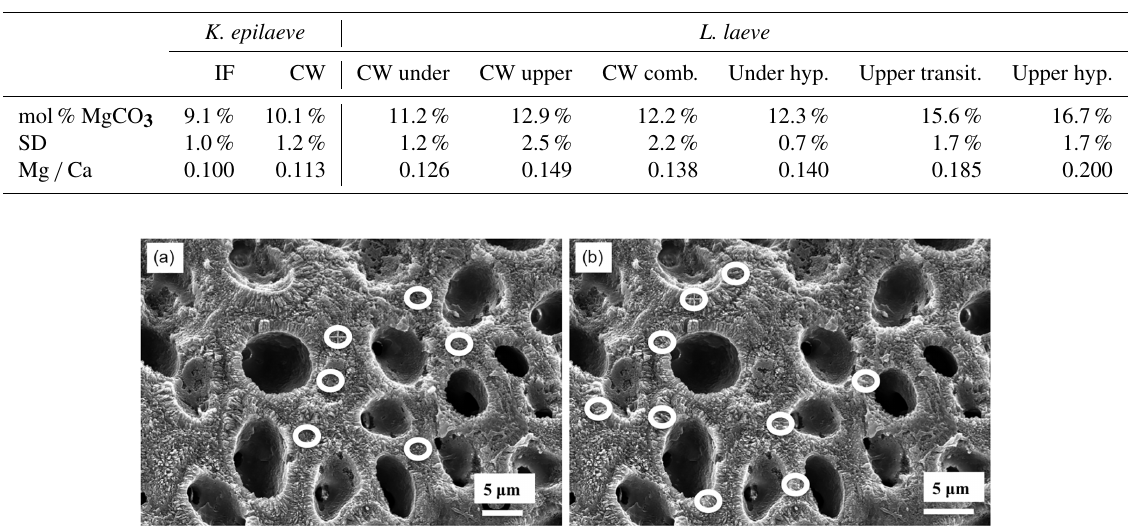
Figure 4. Detail of EDS sites in K. epilaeve (dashed white box in Fig. 2a). (a) EDS sites (white circles) for interfilament. (b) EDS sites for cell wall.